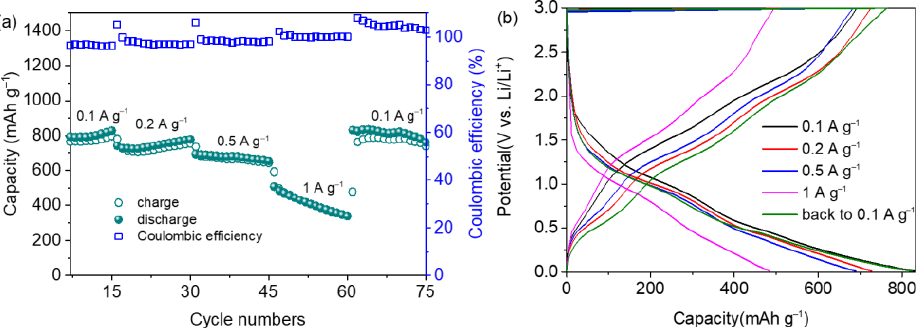
Figure 7. ( a ) Rate performance of the SnO 2 @Ni 6 MnO 8 anode. ( b ) Corresponding charge–discharge curves.